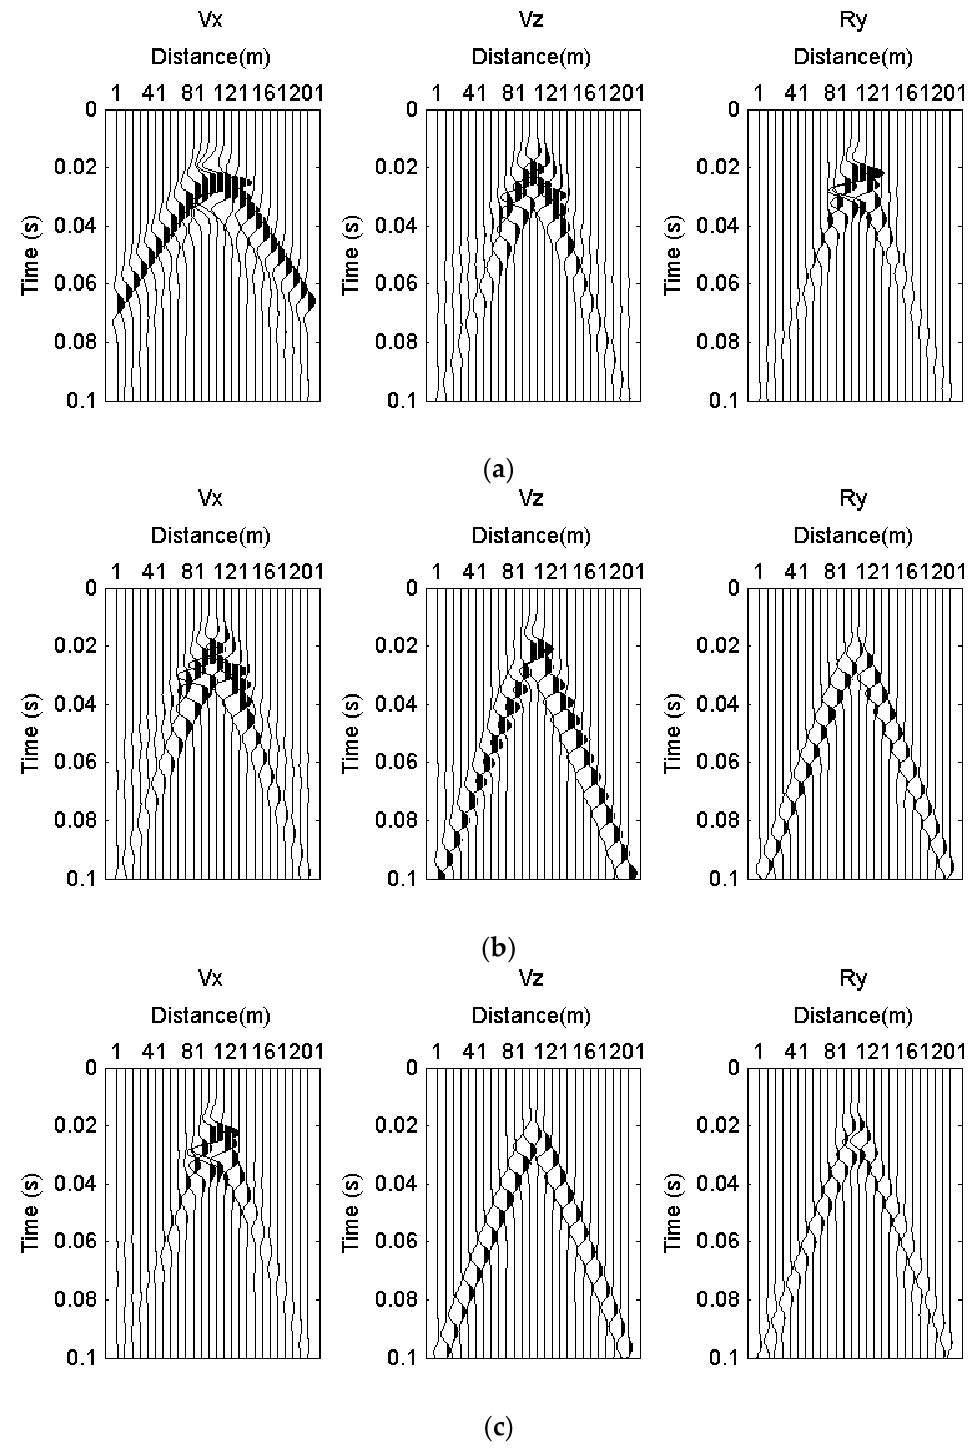
Figure 2. The seismograms. ( a ) The radial concentrated force source. ( b ) The vertical concentrated force source. ( c ) The shear source.